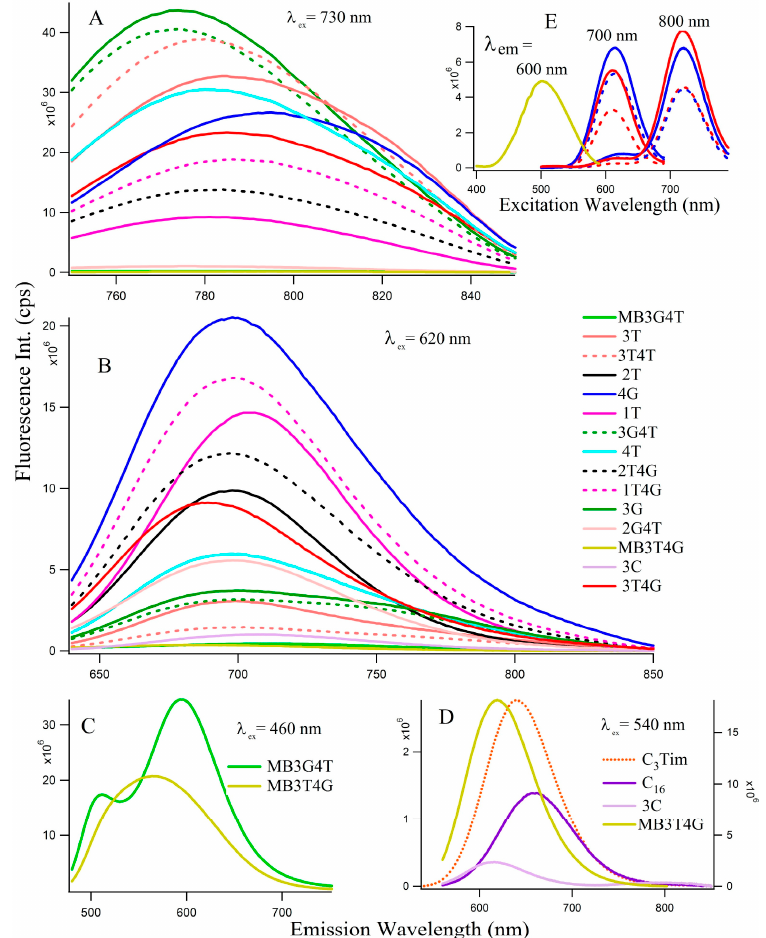
Figure 2. Fluorescence emission spectra of the silvers nanoclusters on various DNA templates (15 μ